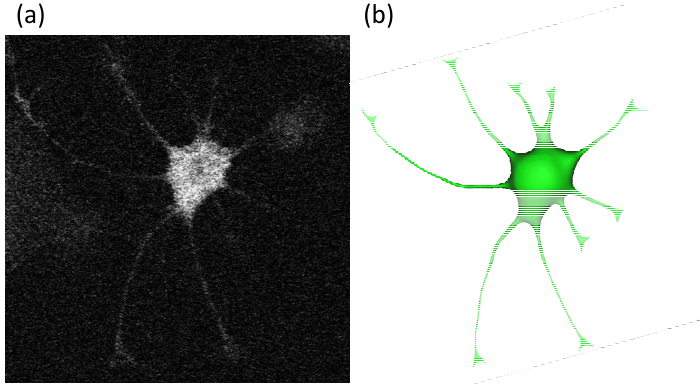
Figure 1. Reconstruction of a single astrocyte cell in 3d. A series of confocal microscopic images ( a ) were reconstructed to build the 3d model of a single astrocyte ( b ). The computational mesh of the stellate astrocyte has 11,390 tetrahedron volume